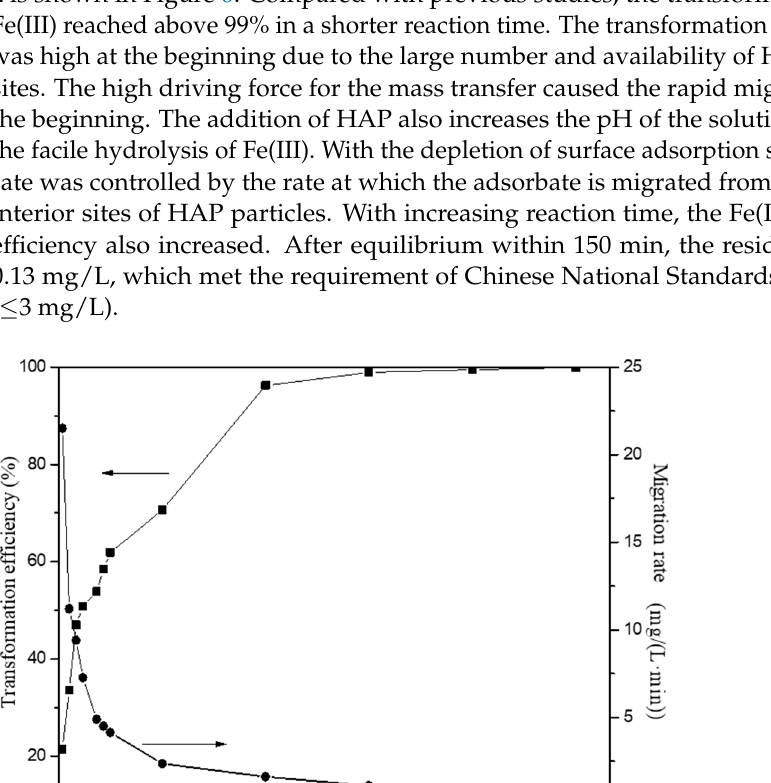
Figure 7 . Effect of temperature on the transformation efficiency of Fe( Ⅲ ) . 3.3. Transformation Mechanisms of Fe( Ⅲ ) In order to investigate the adsorption properties of Fe( Ⅲ ) in the migration and trans- formation process, the experimental equilibrium data were fitted using Langmuir, Freun- dlich and Sips models (Table 2). Adsorption parameters are as follows: C t (mmol/L) is the equilibrium concentration of Fe( Ⅲ ) in the solution, q (mmol/g) is the equilibrium concen- tration of Fe( Ⅲ ) at natural apatite surface, q m (mmol/g) is the maximum adsorption capac- ity, K L (L/mmol) the Langmuir constant related to the energy of adsorption and K (mmol 1 − n